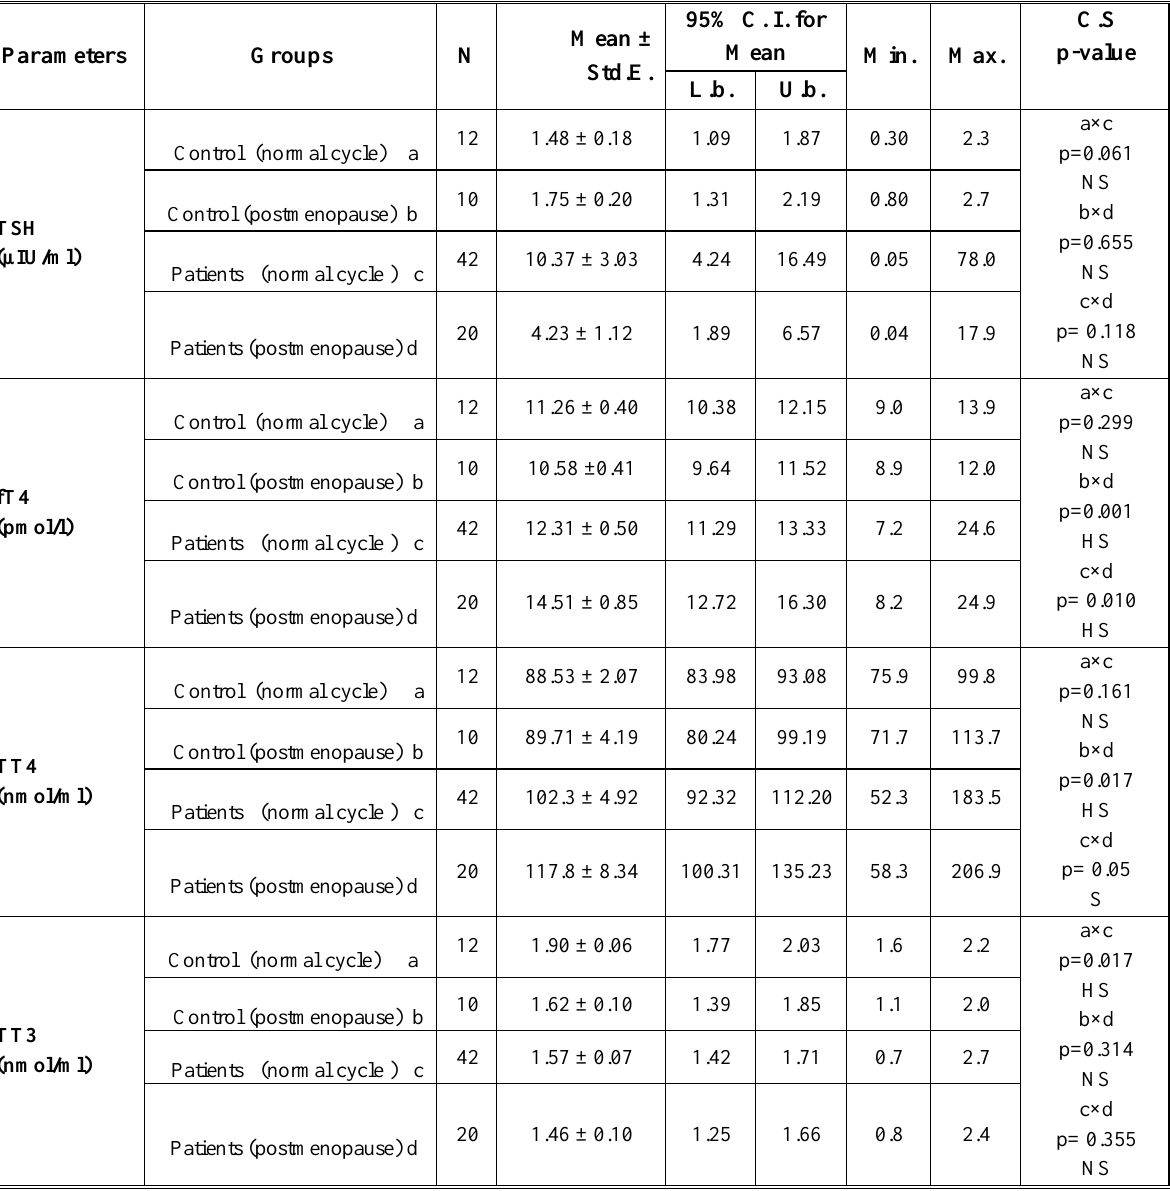
Table 2: Distribution of thyroid hormones levels in patients and control